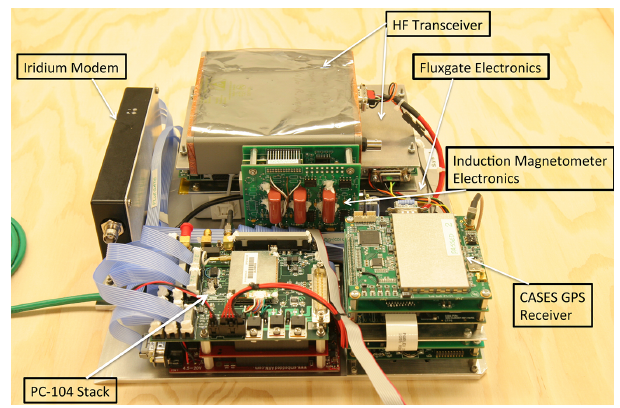
Figure 11. Electronics